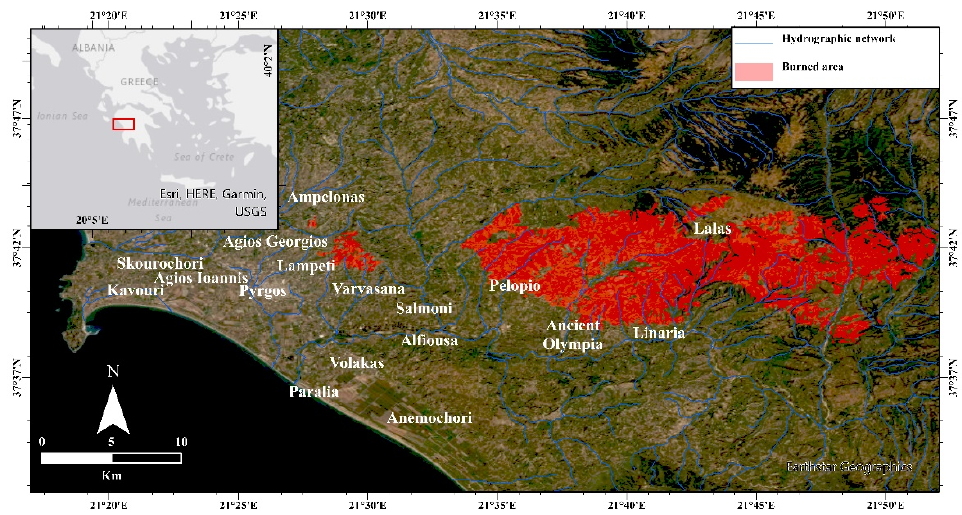
Figure 6. Areas affected in the wider area of Ancient Olympia. The map is available in web map view through the URL https://arcg.is/TW5jy0 .(accessed on 15 May